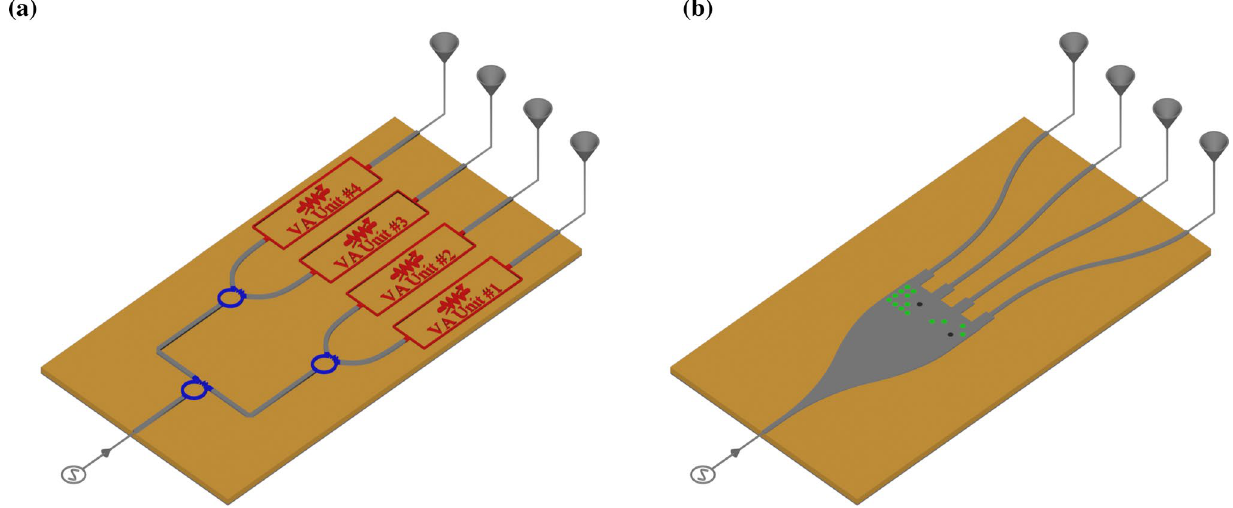
Figure 1. ( a ) Traditional feeding network in sub-array antenna ( b ) new compact and affordable structure to control amplitude level of primary array’s